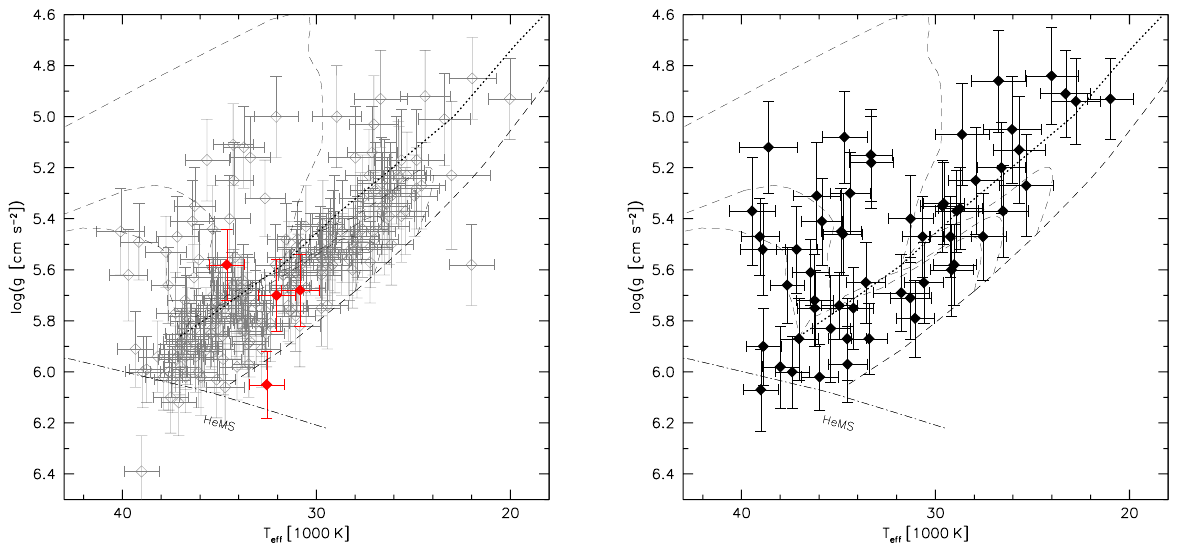
Figure 2. T eff − log g diagrams of our sample (red filled diamonds: thin disk, grey open diamonds: thick disk, black filled diamonds: bona fide halo). The helium main sequence (HeMS) and the HB band are superimposed with HB evolutionary tracks (dashed lines) for subsolar metallicity (log z = −1.48) from Dorman et al. (1993). The three tracks correspond to helium core masses of 0.488, 0.490 and 0.495 M ⊙ (from bottom-left to top-right). The disk sample is shown on the left panel, while the right-hand panel shows the bona fide halo sample.